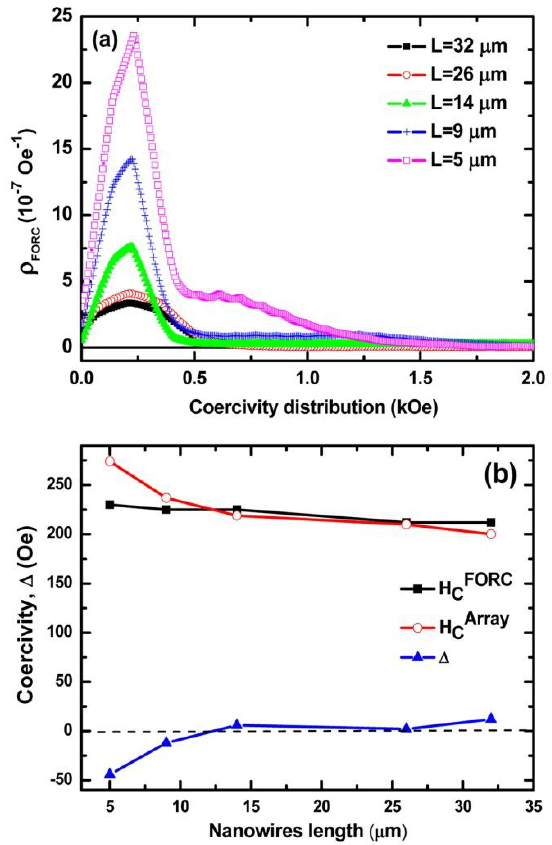
Fig. 8. (a) Coercivity distribution for different samples. (cid:2913)(cid:2885)(cid:2928)(cid:2928)(cid:2911)(cid:2935) (b) H (cid:2913)(cid:2890)(cid:2899)(cid:2902)(cid:2887) , H and ∆ as a function of NWs